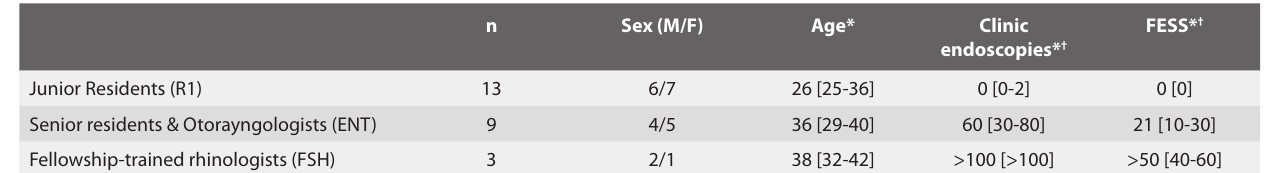
Table 2. Participant characteristics.